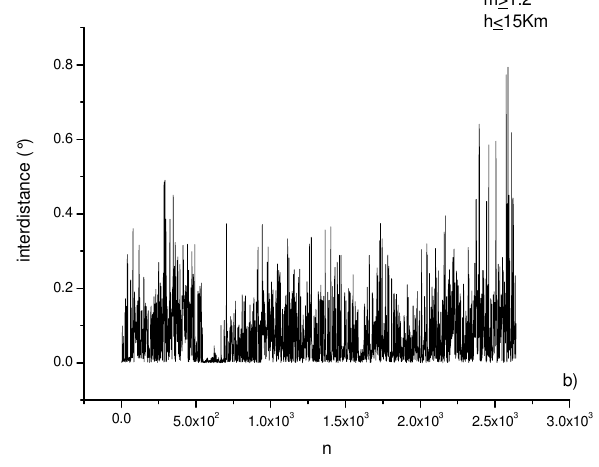
Fig. 8. Interdistance time series of the sequence of the seismic events with magnitude m ≥ 1 . 2 and depth h ≤ 15km.